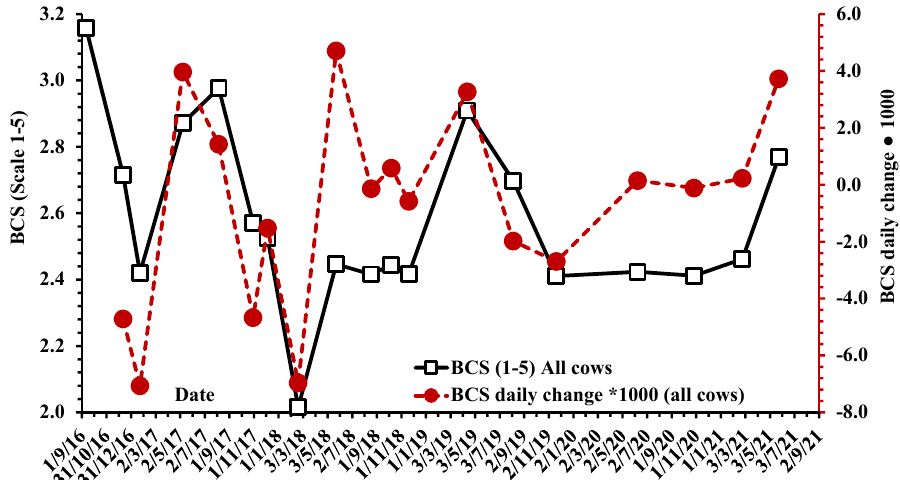
Figure 3. The studied cows’ body condition score (BCS, □ ), on a scale of 1 - 5, and the daily BCS changes ( ● ) (calculated as daily change in BCS × 1000). Dates are given as day/month/year. Cows’ Average BW, MEI and DMI